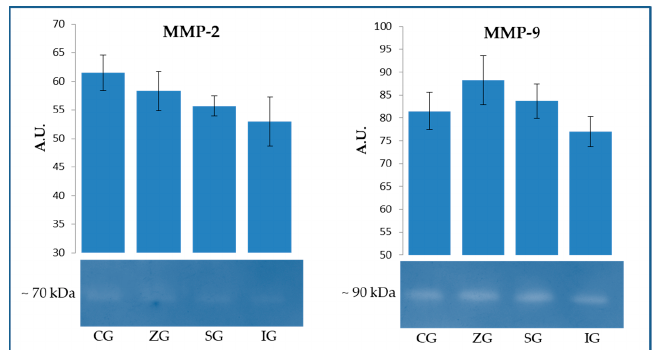
Figure 1. Gelatin-zymography on milk samples obtained from lactating dairy cows fed control diet (CG) and control diet supplemented with zinc (ZG), selenium (SG), and iodine (IG). Analysis was performed in order to obtain information on the enzymatic activities associated to matrix metalloproteinase 2 (MMP-2) and matrix metalloproteinase 9 (MMP-9). The ImageJ software was used to perform the quantitative analysis of visualized spots. Data are reported as mean values expressed in arbitrary unit (A.U.) ± standard